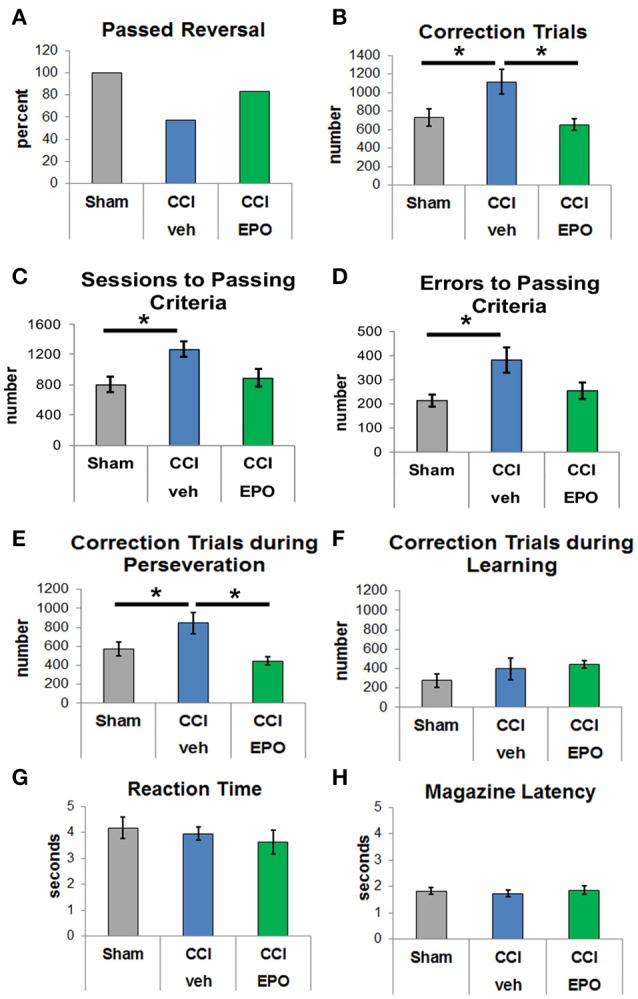
EPO treatment resolves deficits in cognitive flexibility. (A) Fewer vehicle-treated CCI rats passed reversal compared to shams or EPO-treated rats. (B) Vehicle-treated CCI rats required at least 50% more correction trials than shams or EPO-treated CCI rats (two-way ANOVA with Bonferroni's correction). (C) Vehicle-treated CCI rats also required more sessions to achieve passing criteria. (D) Similarly, vehicle-treated CCI rats committed more errors prior to reaching passing criteria. (E) Importantly, vehicle-treated CCI rats showed significant perseveration and required more correction trials during the perseverative phase than shams or EPO-treated CCI rats. (F) By contrast, rats from all 3 groups showed no difference during the learning phase. (G) Similar to VD, rats in all 3 groups demonstrated similar reaction times. (H) Rats in all three groups exhibited similar motivation to retrieve a reward for a correct response (n = 6–8, *p < 0.05).